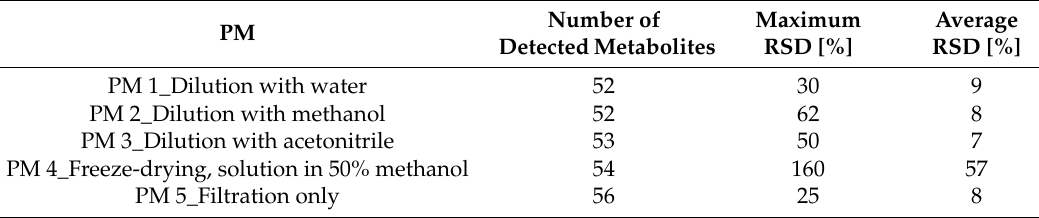
Table 1. Number of metabolites detected using targeted Liquid Chromatography–High-Resolution Mass Spectrometry (LC–HRMS) and repeatability of sample preparation methods evaluated as relative standard deviations of peak areas from triplicate analyses.